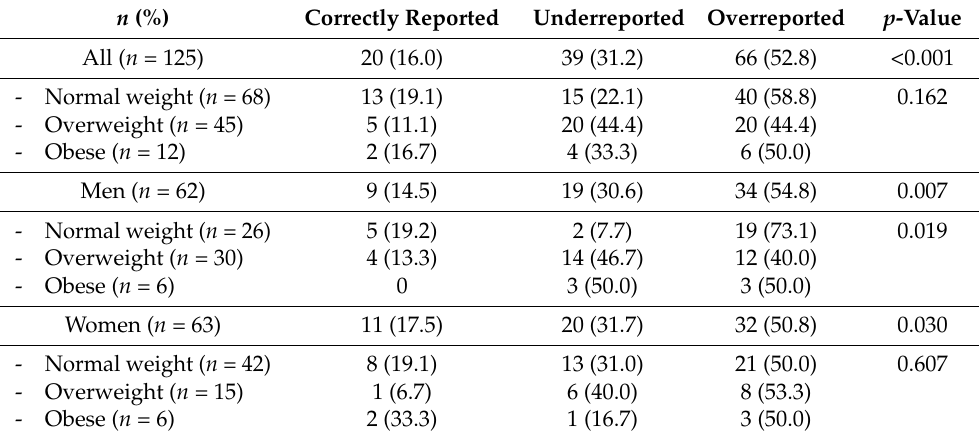
Table 3. Participant who correctly reported, underreported, or overreported body weight, using a relative difference of ± 250 g between measured and self-reported body weight as